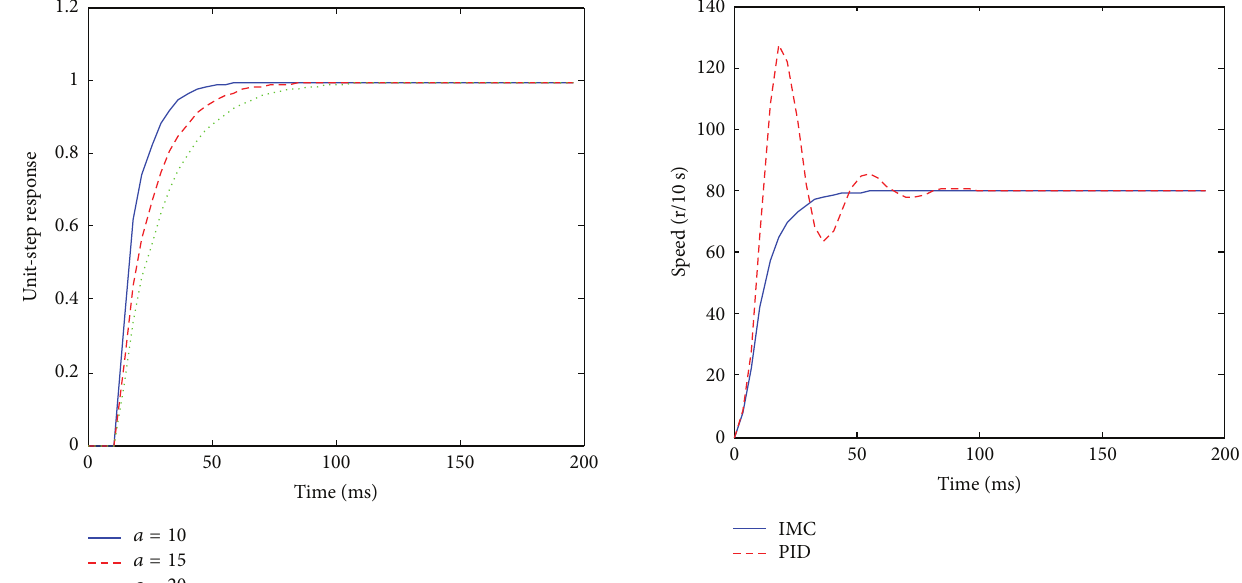
Figure 7: Comparison to the effect of the IMC and the PID controller with step input.